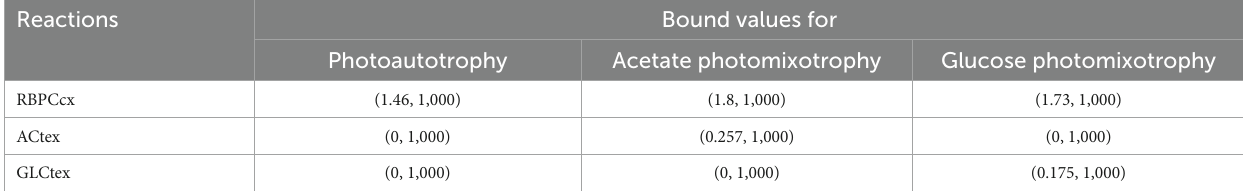
TABLE 4 Values of the lower and upper bounds used to generate condition-specific